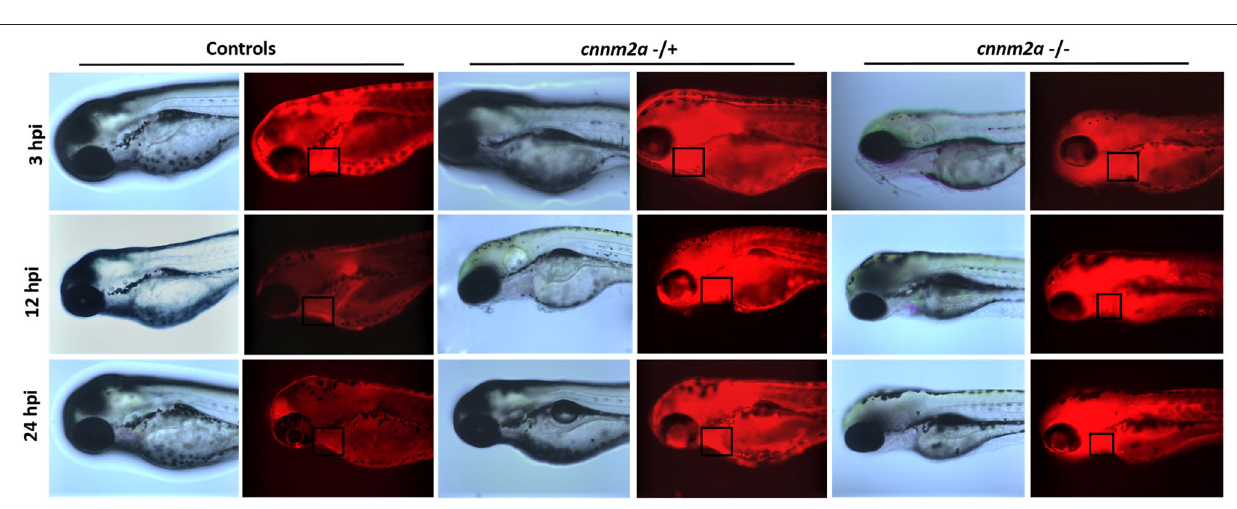
FIGURE 10 | Zebrafish cnnm2a mutant (heterozygote and homozygote) larvae along with wildtype controls micro injected with rhodamine dextran dye in their pericardial sac. Bright field and fluorescent images captured at 3, 12, and 24h post injection represent the inefficiency of cnnm2a mutant larvae to filter the dextran dye through kidney as the controls. Images were captured using Keyence inverted microscope at 40X